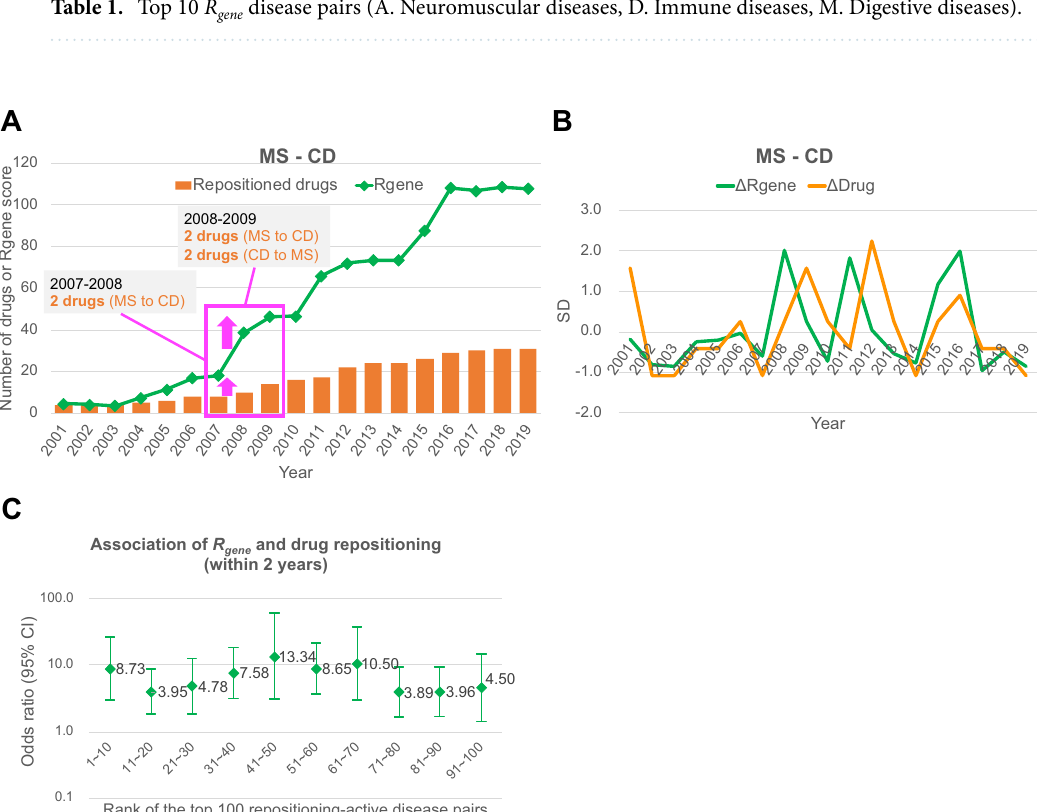
Figure 3. Annual changes of R gene and drug repositioning between disease pairs in recent 20 years. ( A ) Annual changes of R gene and drug repositioning between multiple sclerosis (MS) and Crohn’s disease (CD). R gene increased gradually correlating to that of the number of repositioned drugs during the whole period. Three characteristic surges were seen for both R gene and drug repositioning in 2007–2008, 2010–2011, and 2014–2016. ( B ) For MS and CD pair, annual changes of R gene and drug repositioning were standardized by SD. The three surges of R gene ( ΔR gene ) appeared to precede corresponding surges of drug repositioning ( ΔDrug ) by about a year. ( C ) Odds ratios of R gene and drug repositioning as an explanatory variable and an objective variable, respectively, by logistic regression analyses. The top 100 repositioning-active disease pairs were divided into 10 groups consecutively and examined the predictability by R gene . This analysis validated the ubiquitous predictability by R gene . Note: In fact, 93 disease pairs were used since 7 pairs lacked drug repositioning